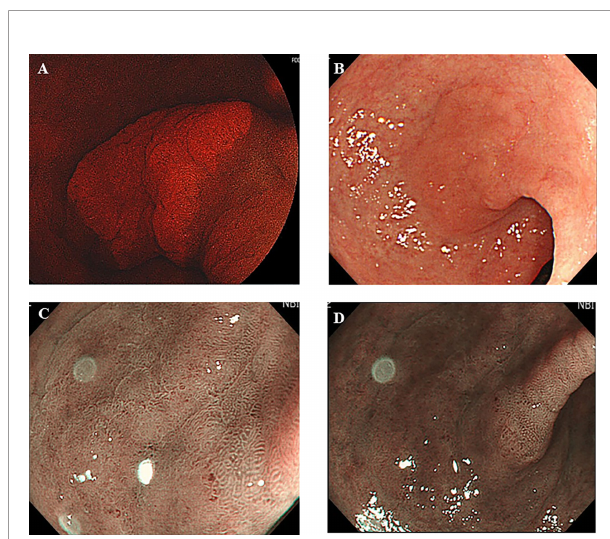
FIGURE 1 | Five aminolebulinic acid-mediated photodynamic diagnosis (5- ALA PDD)-positive lesion (A) that were not clearly identi fi ed by conventional white light imaging (B) only with slightly elevation and narrow band imaging with (C) or without (D) magni fi cation without apparent demarcation during previous examination.